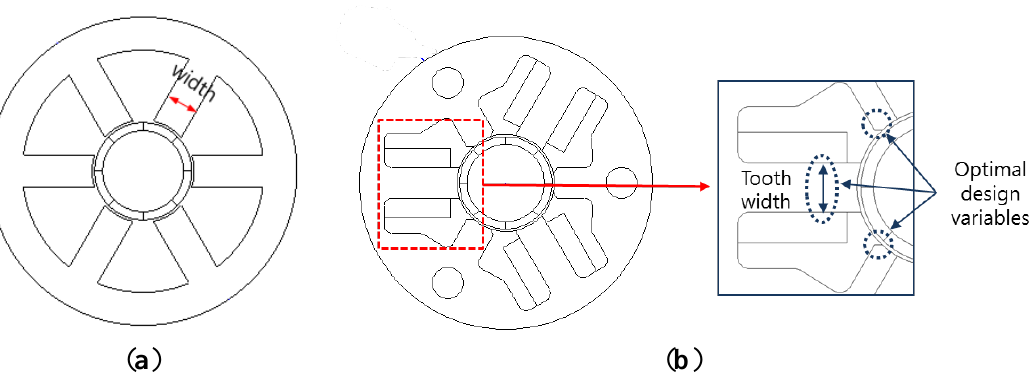
Figure 5. Design variables for the cogging-torque reduction: ( a ) initial model and ( b ) proposed model.